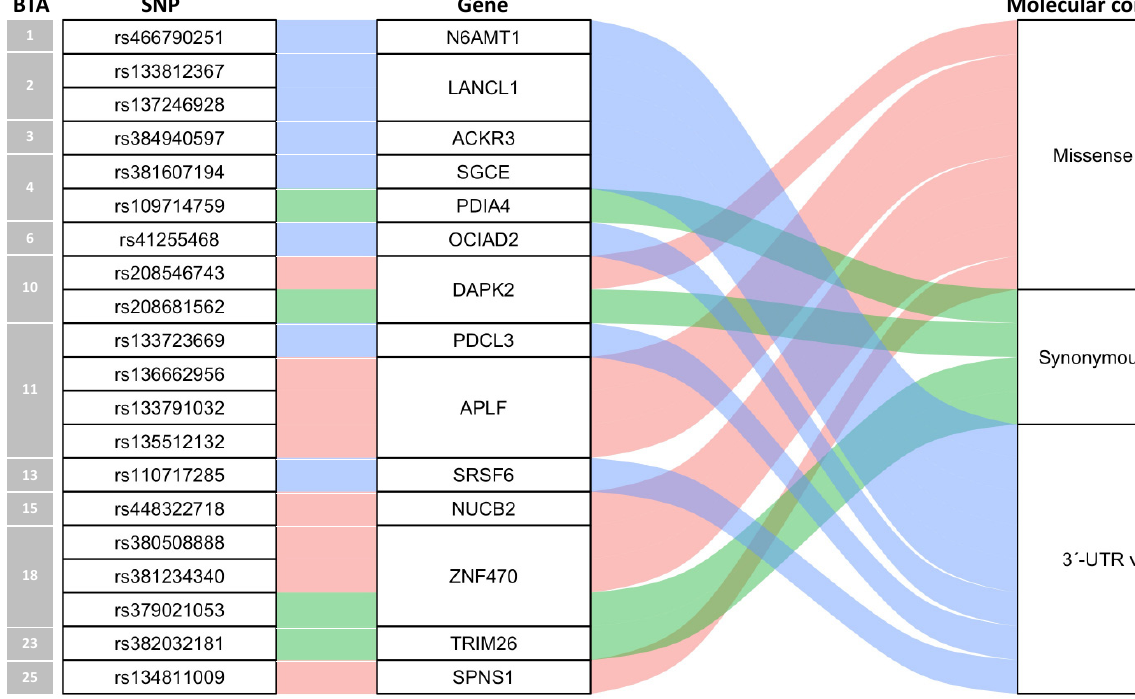
Figure 1. SNPs with monoallelic expressions in Hanwoo.